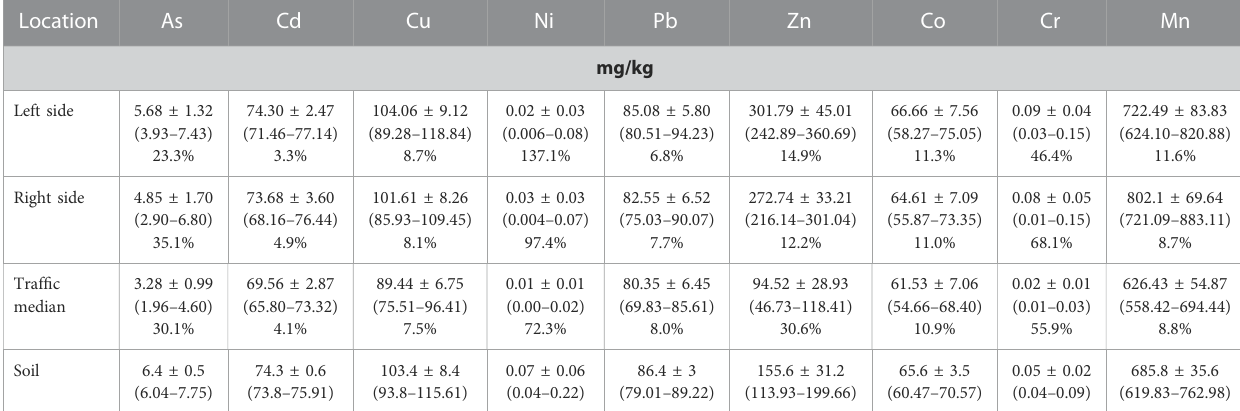
% is the coef fi cient of variation in percentage.